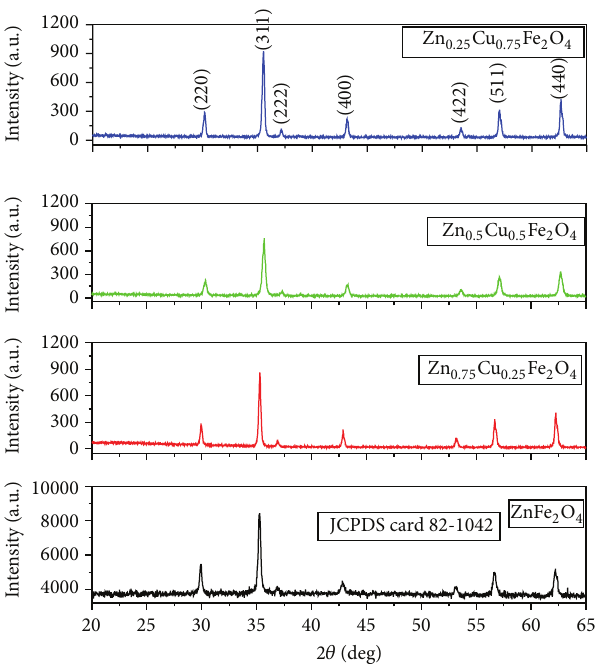
Figure 1: XRD spectra of the zinc-copper ferrite